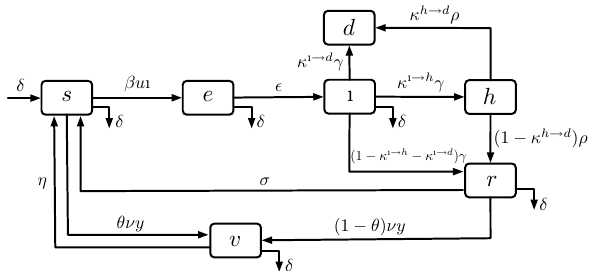
Figure 7. Block diagram of the compartmental model adopted to generate data. The illustrated model is used to describe a single-region. Model equations and extensions to the multi-region model are discussed in “Methods”